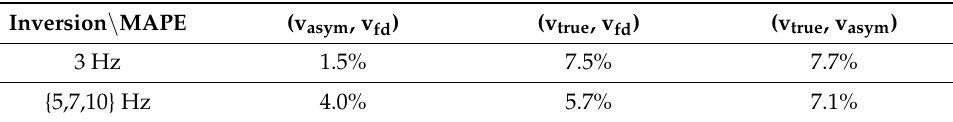
Table 2. The MAPE value between the velocity models obtained via different inversion scenarios: v true is the true velocity model; v fd is the result of the classical full waveform inversion method; v asym is the result of the asymptotic inversion.